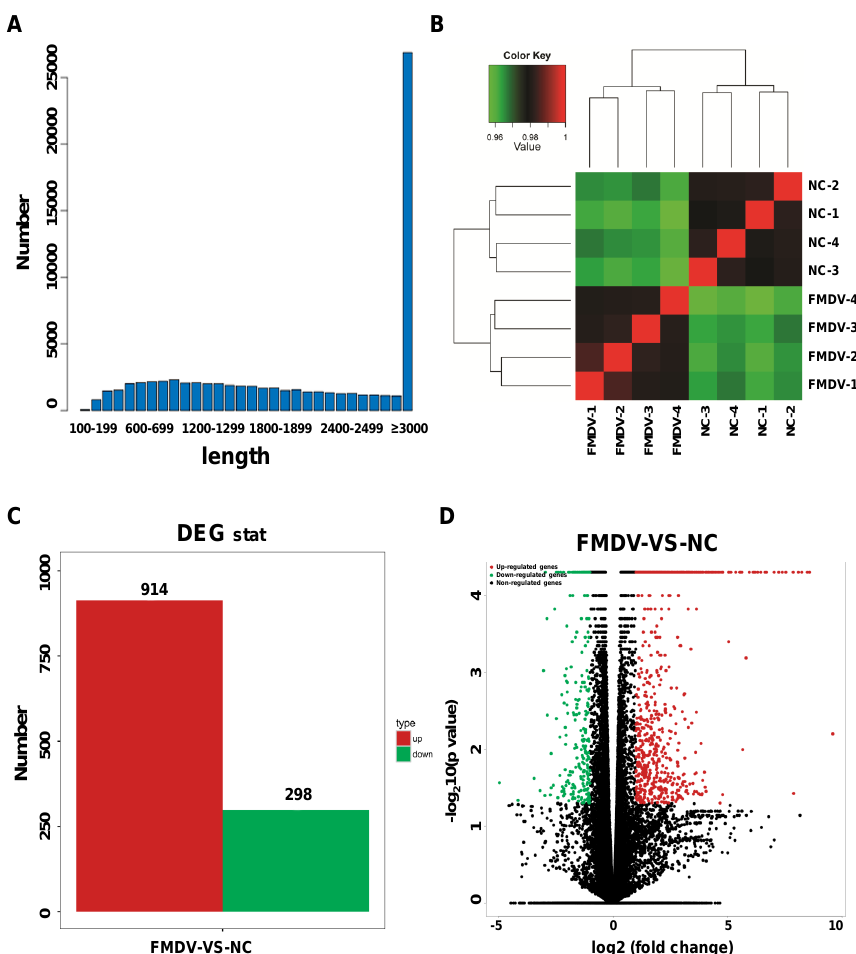
Figure 1. Quality control and statistics of differentially expressed genes (DEGs). ( A ) Length distribution of the assembled transcript, where the x -axis represents the length distribution and the y -axis indicates the number of transcripts at each length. More than 25,000 transcripts had a length equal to or greater than 3000, which was the largest proportion. ( B ) Sample correlation heat map. The green to red color key indicates the Pearson correlation coefficient (R) value, representing lower to higher r -values, respectively, suggesting the sample repeatability in the same group and also reflecting the differences between the two groups. ( C ) Number of differential genes between foot-and-mouth disease virus (FMDV)-treated and non-treated groups. Red represents up-regulated genes and green represents down-regulated genes. The y -axis indicates the number of genes. ( D ) Volcano plots of the distribution of DEGs. The x -axis indicates the fold changes of DEGs; the greater the absolute x -value, the greater the fold change. The y -axis represents the significance of the DEGs; the greater the y -value, the smaller the p -value. Red dots represent up-regulated genes, green dots represent down-regulated genes, and black dots represent not significantly regulated